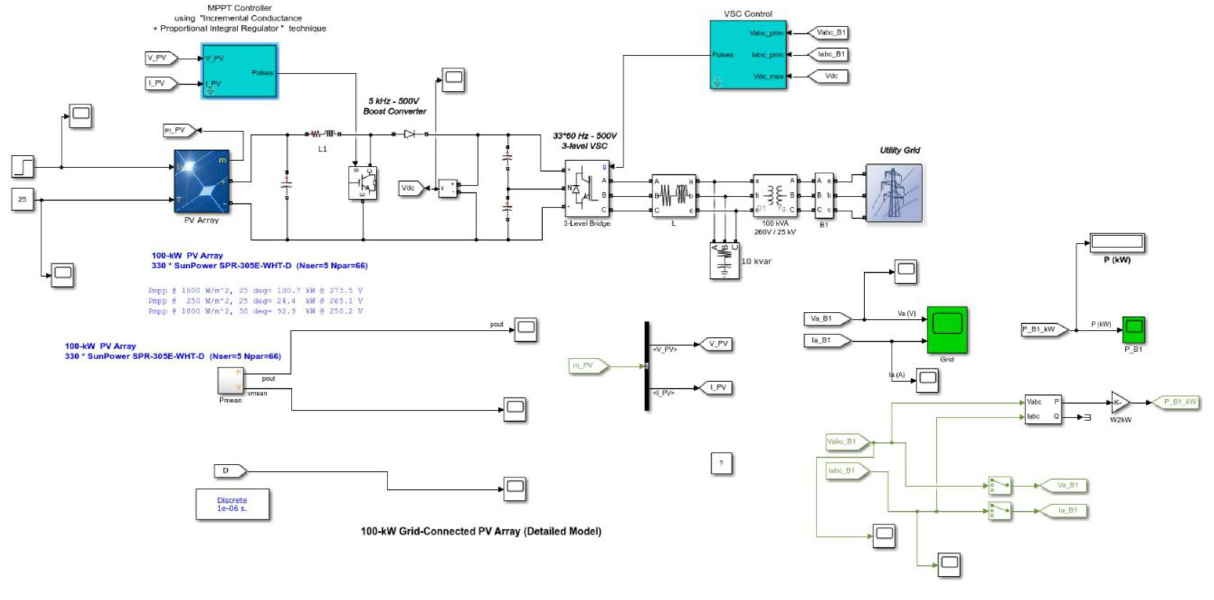
Figure 2. System Construction.